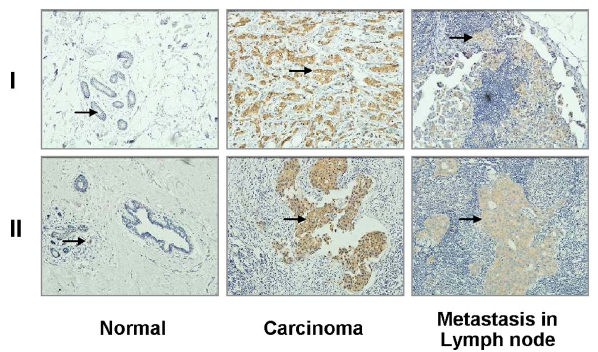
Figure 2. PKC f expressed strongly in carcinoma tissue, but weakly/not in normal tissue and in lymph node metastasis. Samples of IHC images were from two independent individuals (I and II). Arrows point to PKC f signals.